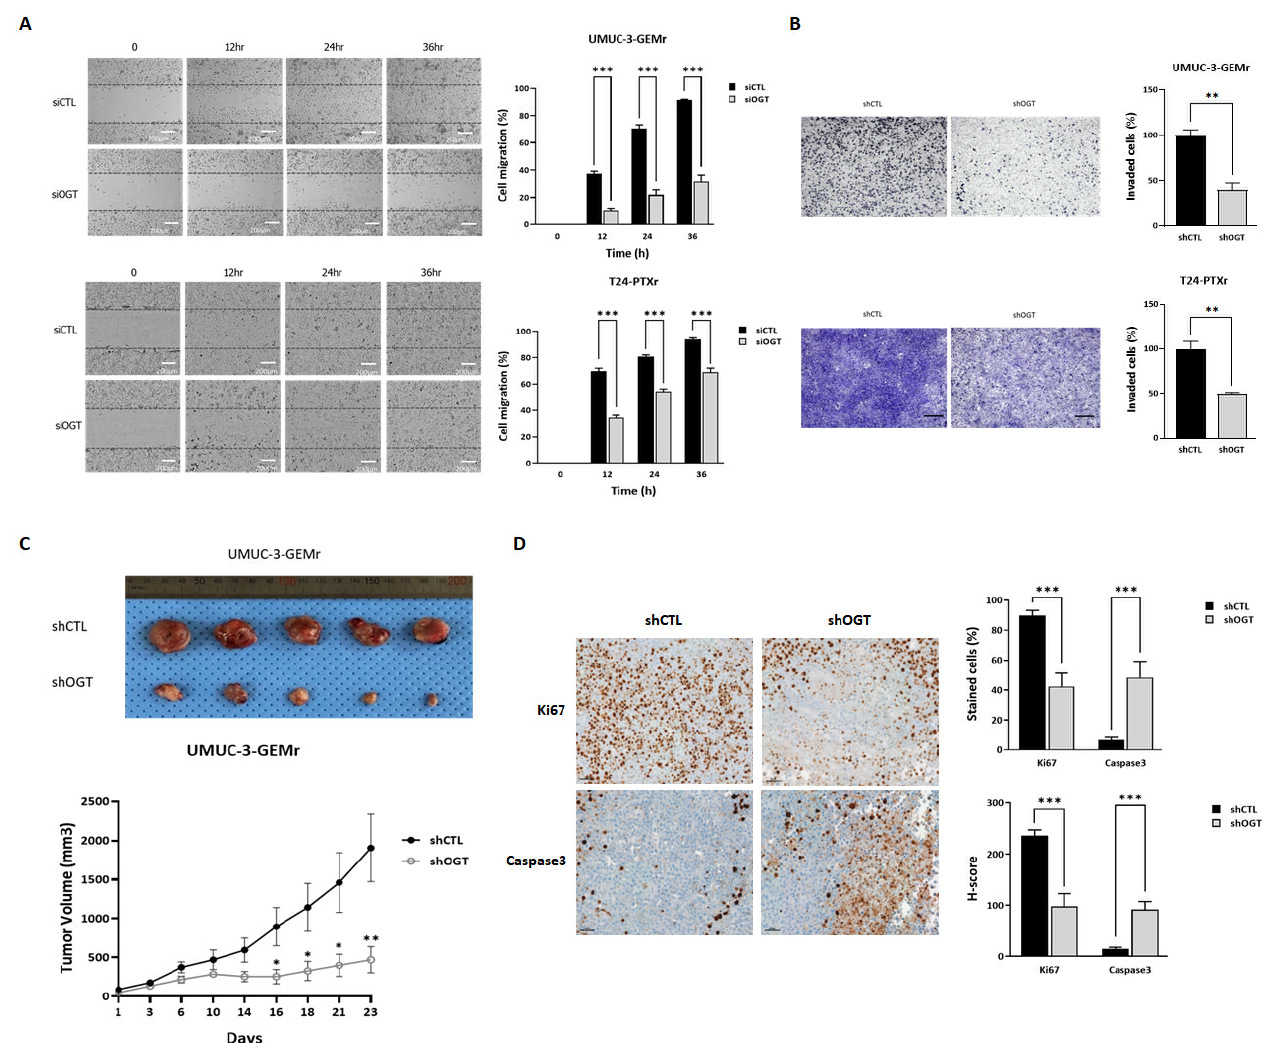
Figure 4. Downregulation of OGT via gene targeting in chemoresistant UCB cells suppressed cell migration, invasion, and subcutaneous xenograft tumor growth via the inhibition of cell proliferation and the induction of cell apoptosis. ( A ) UMUC-3-GEMr and T24-PTXr cells were reverse transfected with either siCTL or siOGT and cell migration was examined using a wound healing assay. Images of the migrated cells were acquired with Operetta CLS at 0, 12, 24, and 36 h. The data represent at least three independent experiments and error bars indicate the mean ± SEM. Scale bar, 200 µ m. ( B ) The in vitro invasion capability of UMUC ‐ 3 ‐ GEMr and T24 ‐ PTXr cells was analyzed using the Boyden Chamber assay. UMUC ‐ 3 ‐ GEMr and T24 ‐ PTXr cells stably expressing shCTL or shOGT were incubated for 48 h. The data represent at least three independent experiments and error bars indicate the mean ± SEM. Scale bar, 50 μ m. ( C ) Representative images of tumors from shCTL (top) and shOGT cells (bottom). The mice were injected subcutaneously with UMUC ‐ 3 ‐ GEMr cells stably expressing shCTL or shOGT (5 × 10 6 /mouse). Tumor size was measured at the indicated time points and, after 4 weeks, the tumors were removed for morphological and histological examination. ( D ) Representative images of immunohistochemistry from tumor tissues and quantified H ‐ scores of Ki ‐ 67 and Caspase 3 from tumor tissues. Tumors derived from shCTL or shOGT UMUC3 ‐ GEMr cells were dissected 6 weeks after cell inoculation and embedded in paraffin, and tumor sections were stained with antibodies against Ki ‐ 67 or Caspase 3. Error bars indicate the mean ± SEM for three independent regions each. Scale bars, 100 μ m. For all panels * p < 0.05; ** p < 0.01; *** p < 0.001.